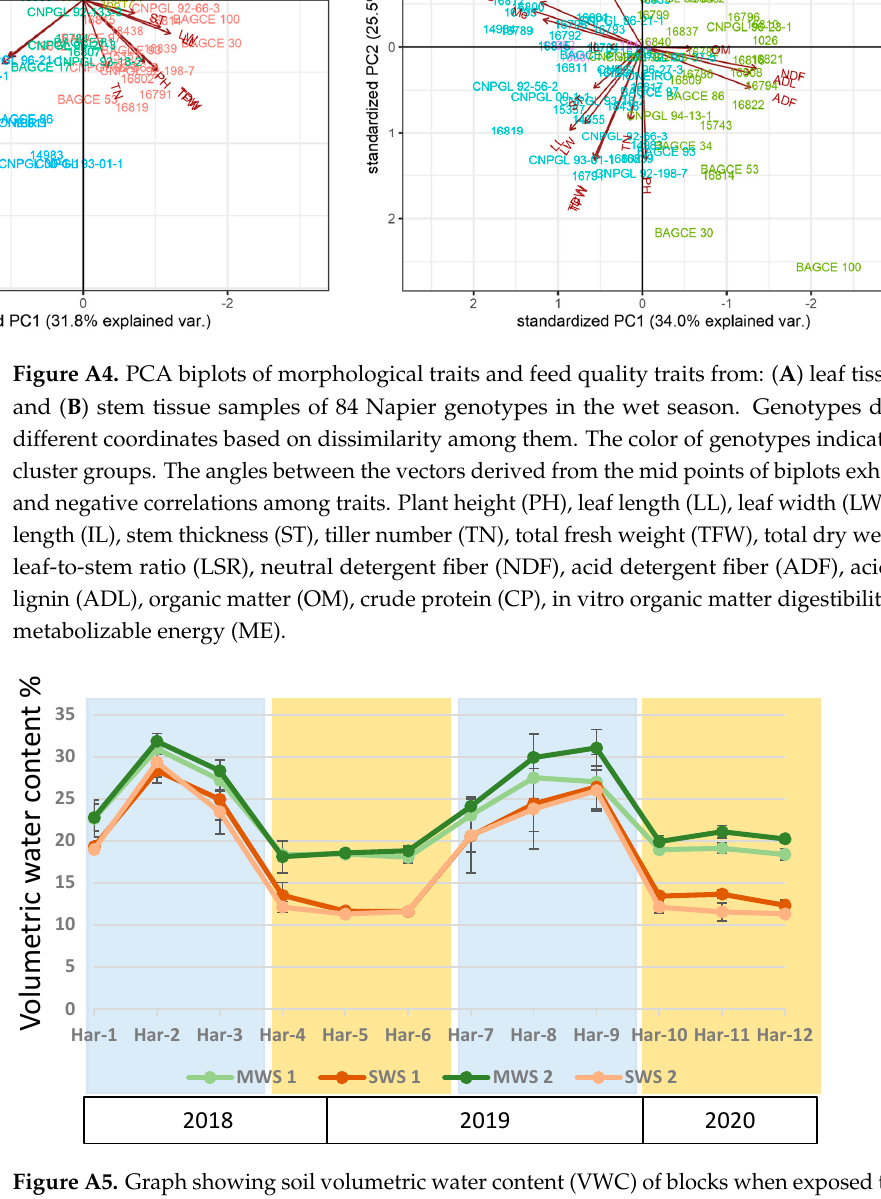
Figure A5. Graph showing soil volumetric water content (VWC) of blocks when exposed to moderate water stress (MWS 1 and MWS 2) and severe water stress (SWS 1 and SWS 2) in replications 1 and 2 of the trial. The soil VWC was calculated using the average of up to a depth of 50 cm. The blue-shaded regions show the rainy (wet) season; the yellow-shaded regions show the dry season. The rectangle box at the bottom indicates the experiment year.